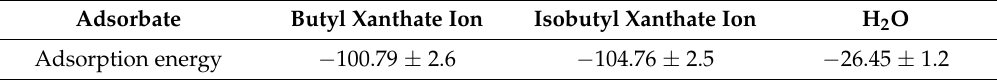
Table 2. Comparison of adsorption energies of different adsorbates on pyrite (100) surface (kJ/mol).